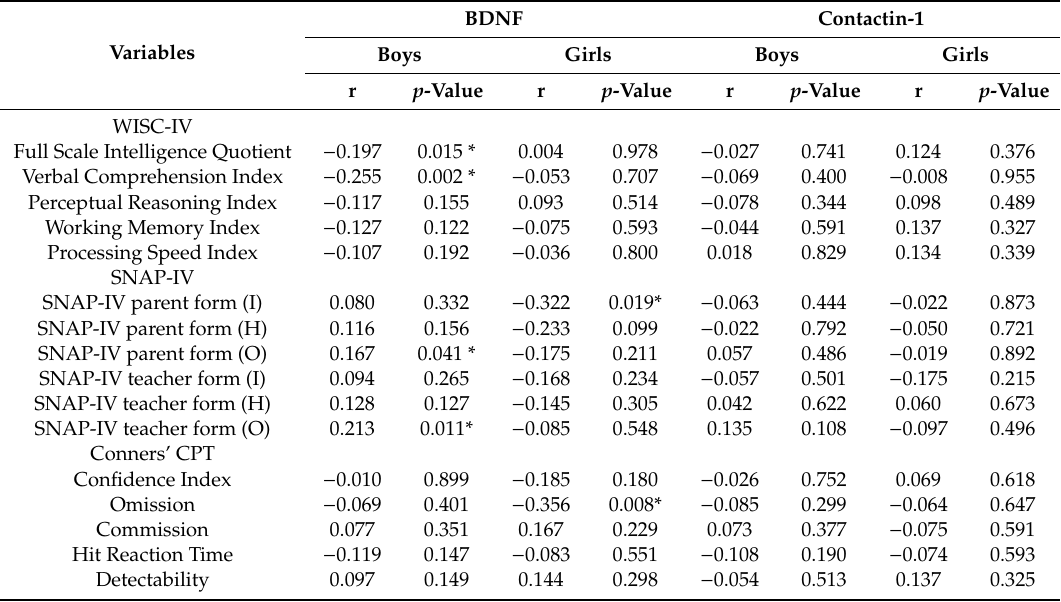
Table 2. Correlation among BDNF and contactin-1 and clinical assessments in boys and girls among patients with ADHD and healthy controls, respectively a